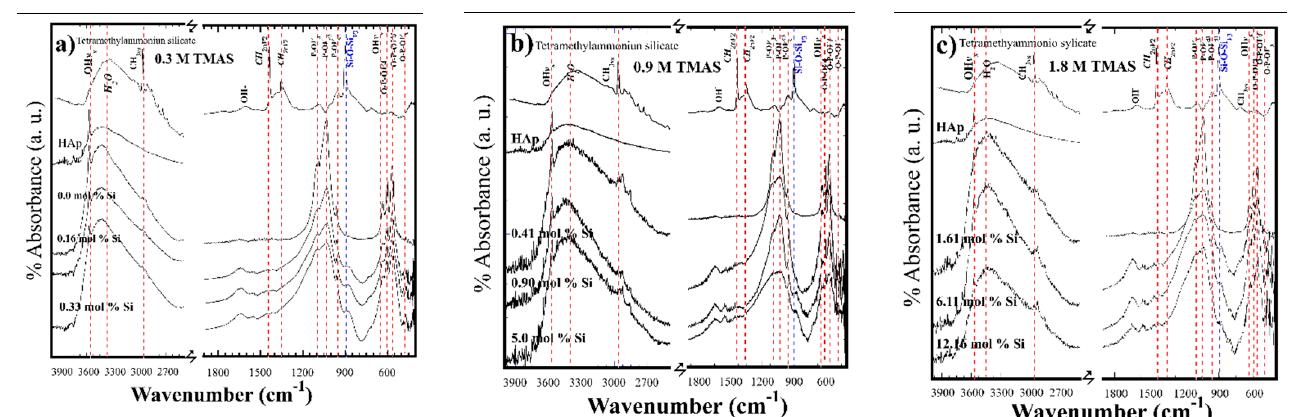
Figure 3. Fourier transform infrared (FT-IR) spectrum analysis of the Si-HAp powders obtained by microwave-assisted hydrothermal process at 150 ◦ C for 1 h using different concentrations of [(C 4 H 13 NO 5 Si 2 ) (TMAS)]: ( a ) 0.3 M; ( b ) 0.9 M, and ( c ) 1.8 M.